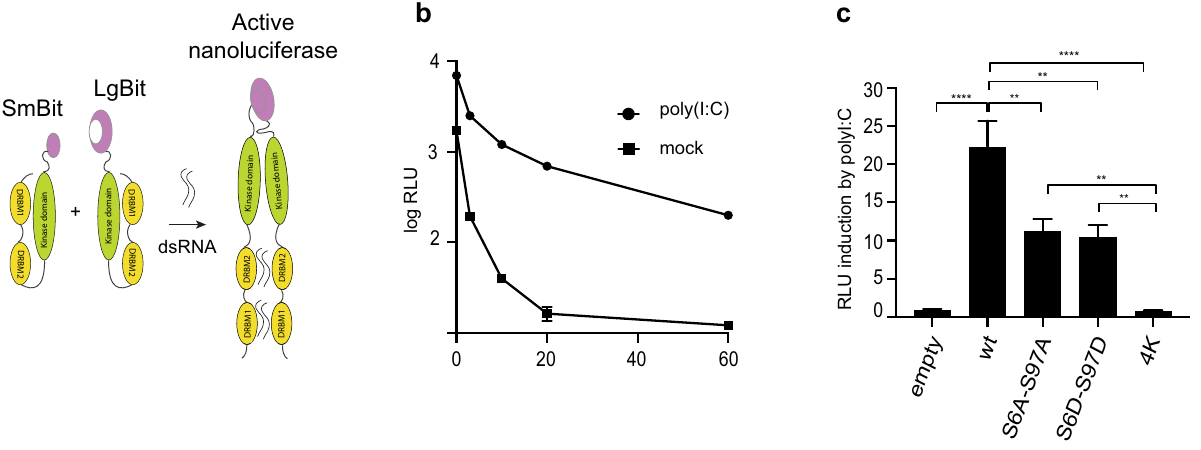
Figure 7. PKR dimerization assay. ( a ) Principle of the PKR dimerization assay based on split nanoluciferase: PKR constructs C-terminally tagged with nanoluciferase SmBit and LgBit fragments are co-expressed in PKR-KO cells. Upon poly(I:C) transfection, PKR dimerization leads to the assembly of active nanoluciferase. ( b ) Kinetics of nanoluciferase activity measured after substrate addition, for wt PKR, in mock-transfected cells and in cells transfected with poly(I:C) for 2 h before substrate addition. ( c ) Graphs show the mean and SEM of nanoluciferase activity induction following poly(I:C) transfection in cells that co-expressed wt or mutant PKR linked to the Sm and Lg Bits of nanoluciferase (homodimerization assay). Luciferase activity was measured 5 min after substrate addition. Significance is shown for multiple one-way ANOVA comparisons with WT PKR and with the negative control 4 K. Graphs were generated with Excel 2011 (Microsoft). Statistical analysis was performed using Prism7